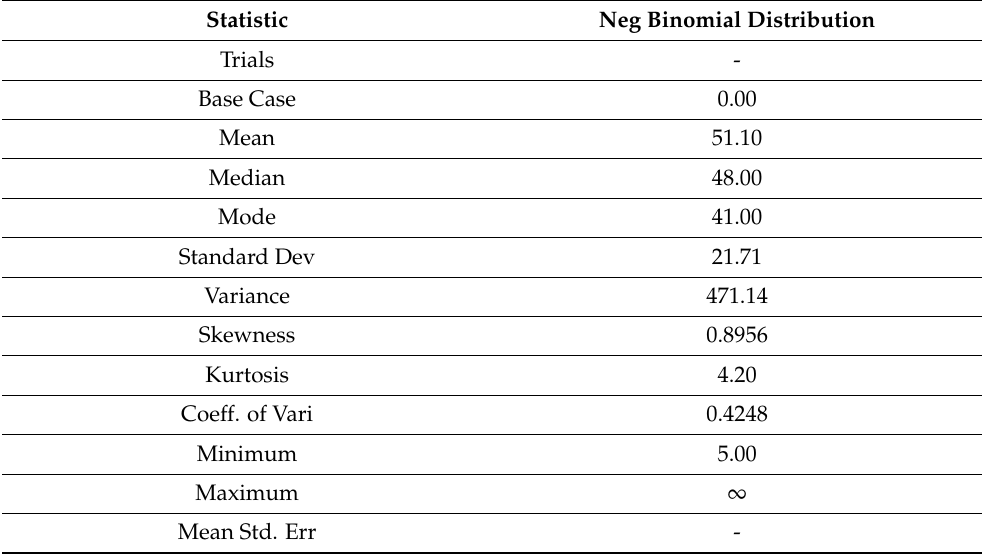
Table 9. Descriptive statistics of the present value distribution for the future incomes from ac- commodation rental facilities for 10 years in Bratislava.